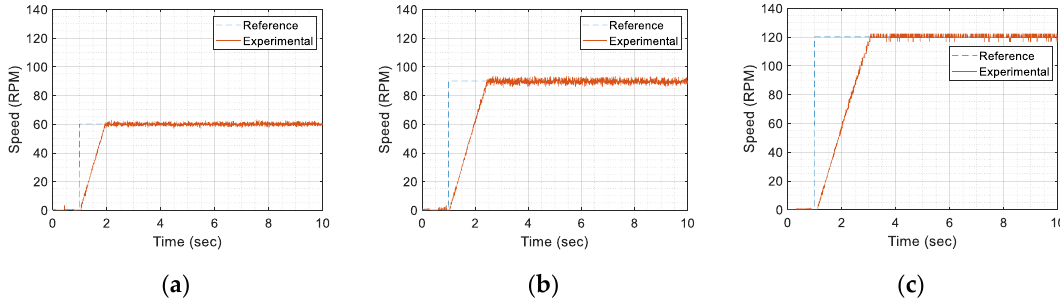
Figure 12. The speed response with a PI controller: ( a ) 60 RPM; ( b ) 90 RPM; ( c ) 120 RPM.